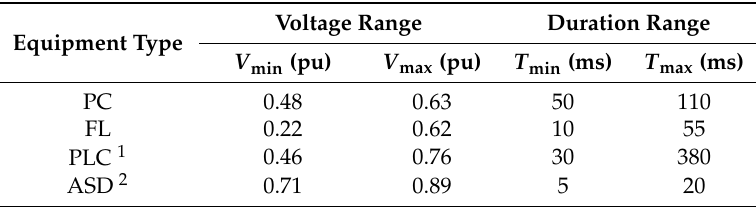
Table 1. Threshold values of the sensitive equipment.